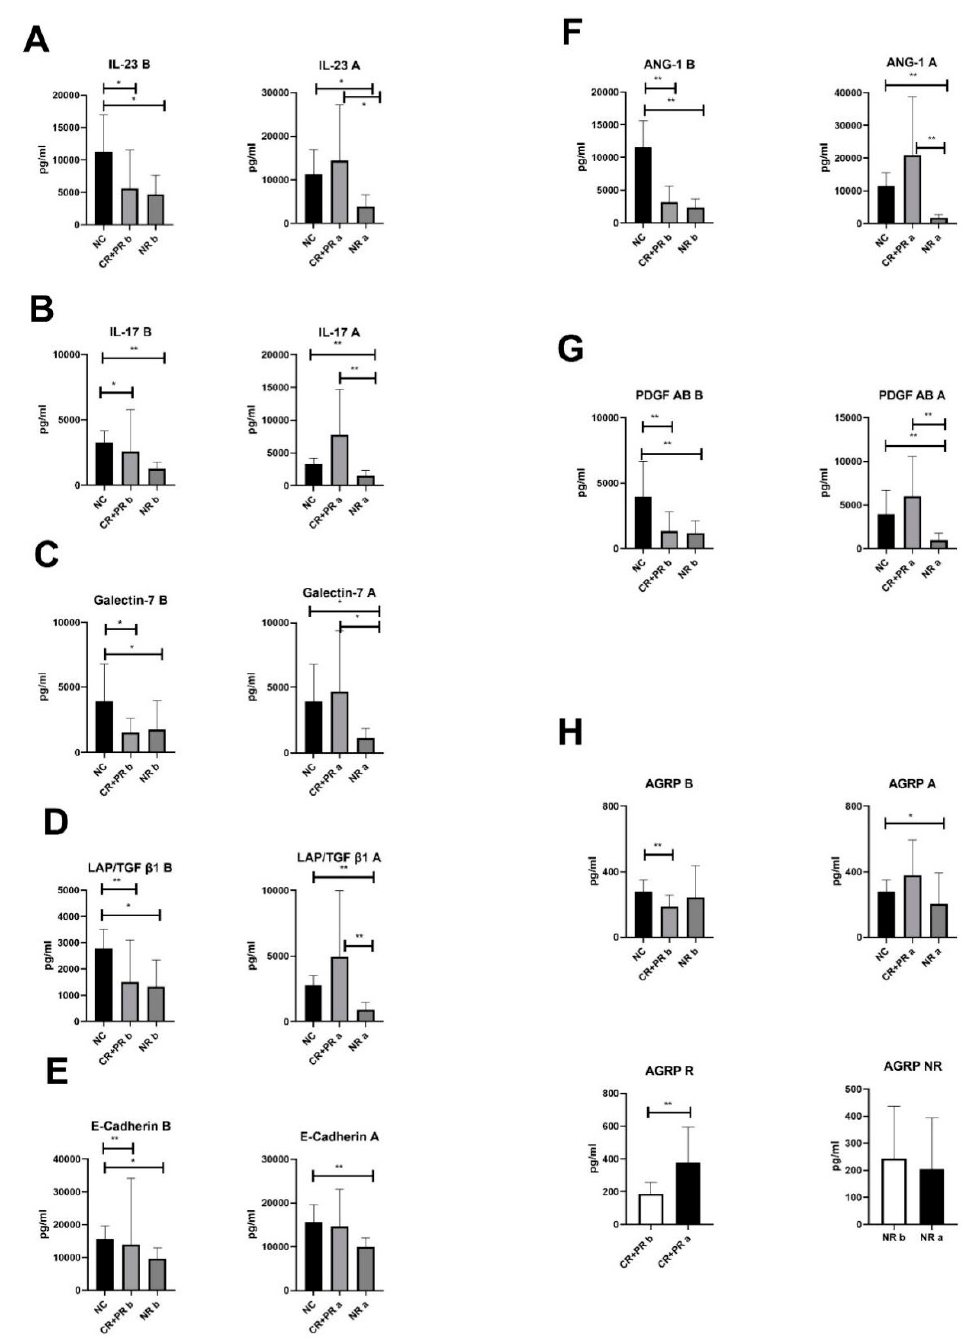
Figure 1. Changes of serum cytokines in ITP patients. ( A ) Changes of serum IL-23 in ITP patients; ( B ) Changes of serum IL-17 β in ITP patients; ( C ). Changes of serum Galectin-7 in ITP patients; ( D ) Changes of serum LAP/TGF β 1 in ITP patients; ( E ) Changes of serum PDGF- αβ 1 in ITP patients; ( F ) Changes of serum ANG-1 in ITP patients; ( G ) Changes of serumE-cadherin in ITP patients; ( H ) Changes of serum AgRP in ITP patients; b: before treatment; a: after treatment; CR: complete remission; PR: partial remission; NR: no remission; * p < 0.05, ** p < 0.01. student t test and Wilcoxon rank-sum (Mann-Whitney) test were used for data fulfilled normal distribution and for those did not,